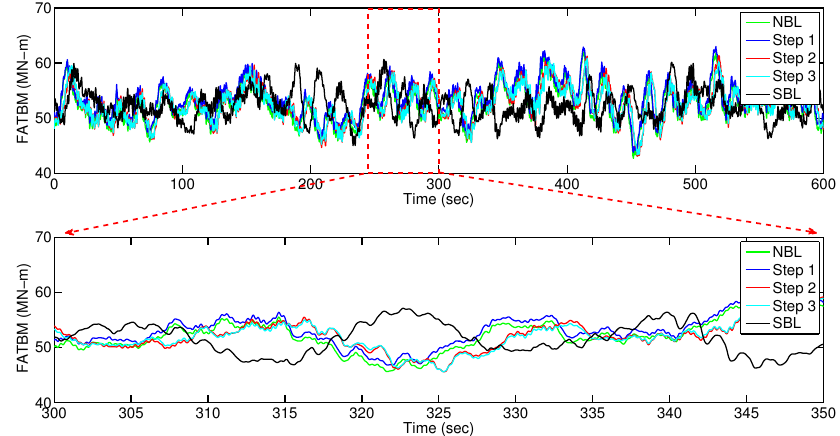
Figure 15. Comparison of fore-aft tower bending moment (FATBM) time series for a single case (control).